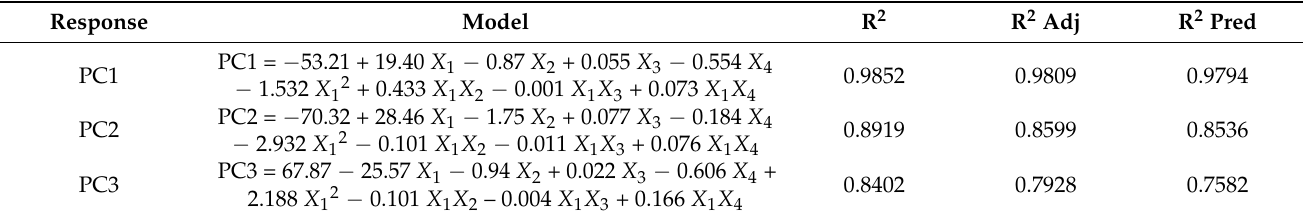
Table 5. Statistical models of Principal Component Analysis (PCA) applied to the three main compo- nents (PC1, PC2 and PC3) of P. pentosaceus fermentation in MRS broth.